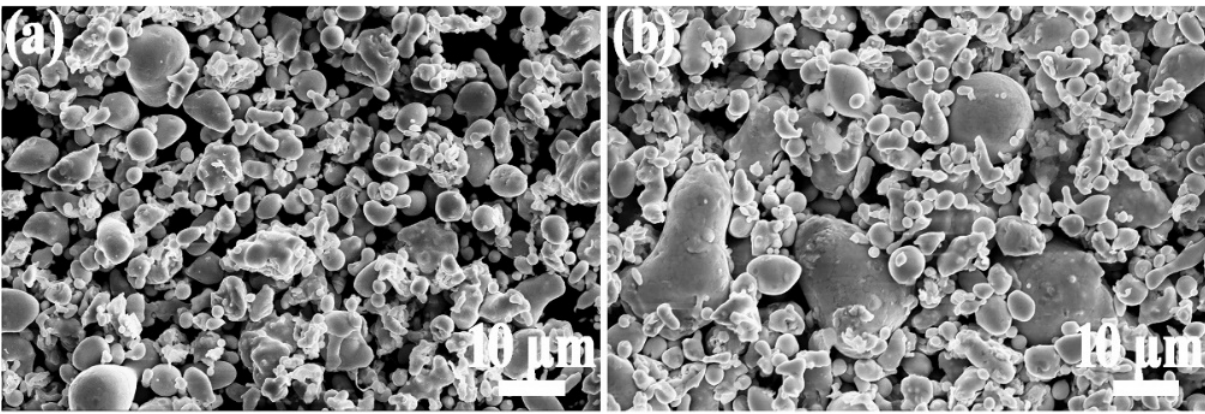
Figure 4. Comparison of Fe-Si-Cr powders: ( a ) Fe-Si-Cr raw powder, ( b ) Fe-Si-Cr phosphated powder. The energy spectrum characteristics of the powder after phosphating are shown in Figure 5. It can be clearly observed that the p element is evenly distributed on the surface of the powder, which indicates that a phosphate layer is formed on the surface of the Fe-Si-Cr powder. The presence of phosphate can improve the resistivity of Fe-Si-Cr powder so as to ensure a relatively low eddy current loss and good processability [36].